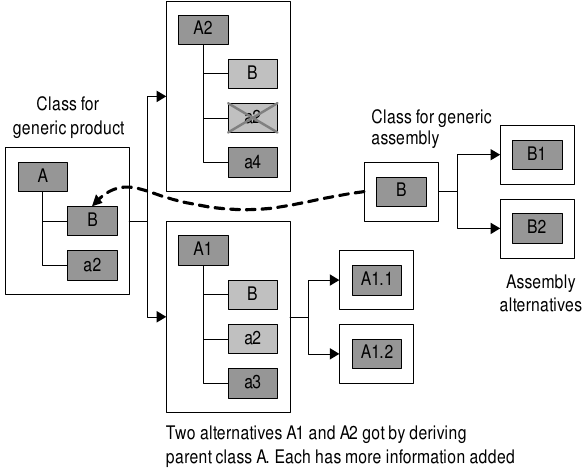
Fig 2. Inheritance example of generic